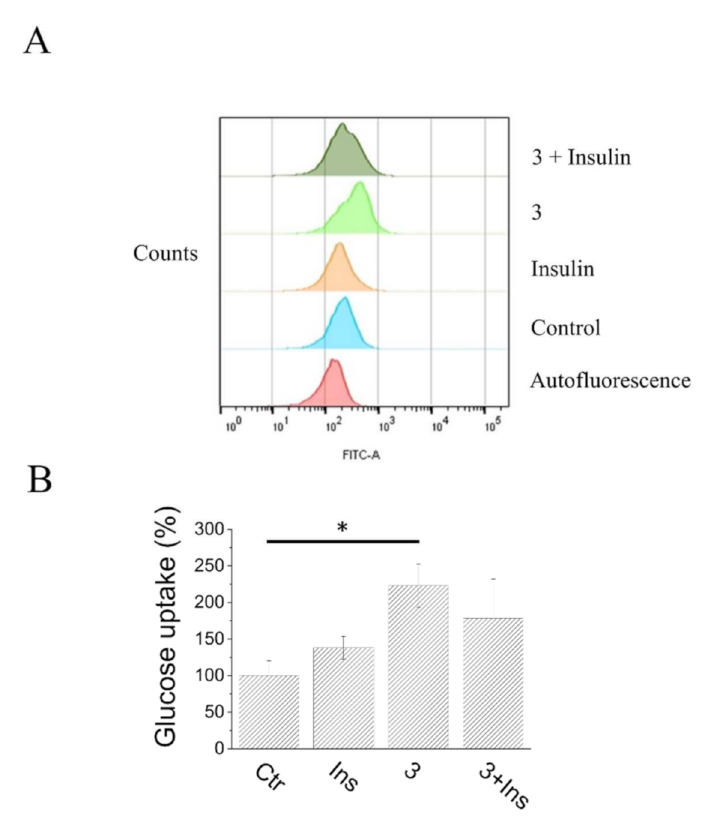
Figure 13. Glucose uptake assay. C2C12 cells were treated with 10 nM insulin, 20 µ M compound 3 or 3 -insulin combination and then incubated in the presence of 2-NBDG for 3 h. After that, the glucose uptake was analysed by flow cytometry analysis. Each test was carried out in quadruplicate. For each test, 10,000 events at least were analysed. ( A ), quantification of the mean fluorescence values of C2C12 cells. Data represents the mean value ± SD ( n = 4). Statistical analysis was carried out using one way ANOVA followed by Tukey’s HSD test for pairwise comparisons. * p < 0.05. ( B ), representative cell fluorescence distribution obtained by analysing data with the FlowJo software. Red, cells autofluorescence; light blue, control cells; orange, C2C12 cells stimulated with 10 nM insulin; green, C2C12 cells stimulated with 20 µ M 3 ; dark green, C2C12 cells stimulated with 3 - insulin